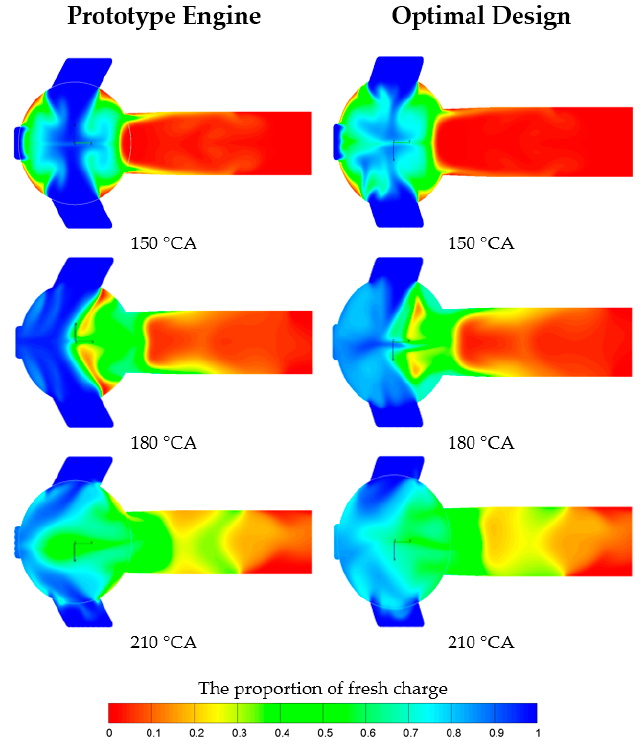
Figure 20. Z cross-sectional views of the prototype engine simulation case and optimal design simulation case under the partial load operating condition. Energies 2017 , 10 , x FOR PEER REVIEW